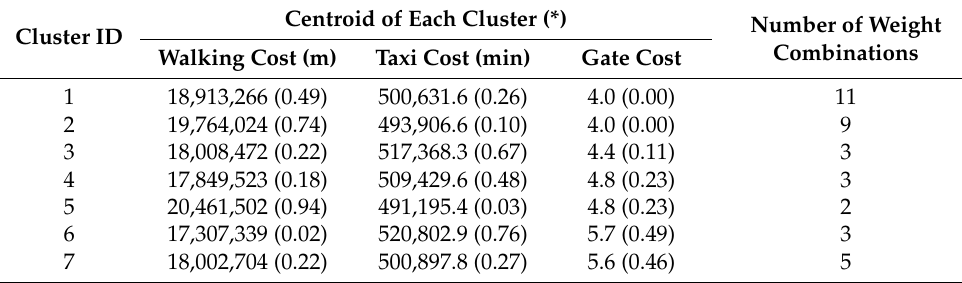
Table 5. Cluster analysis results of different weight